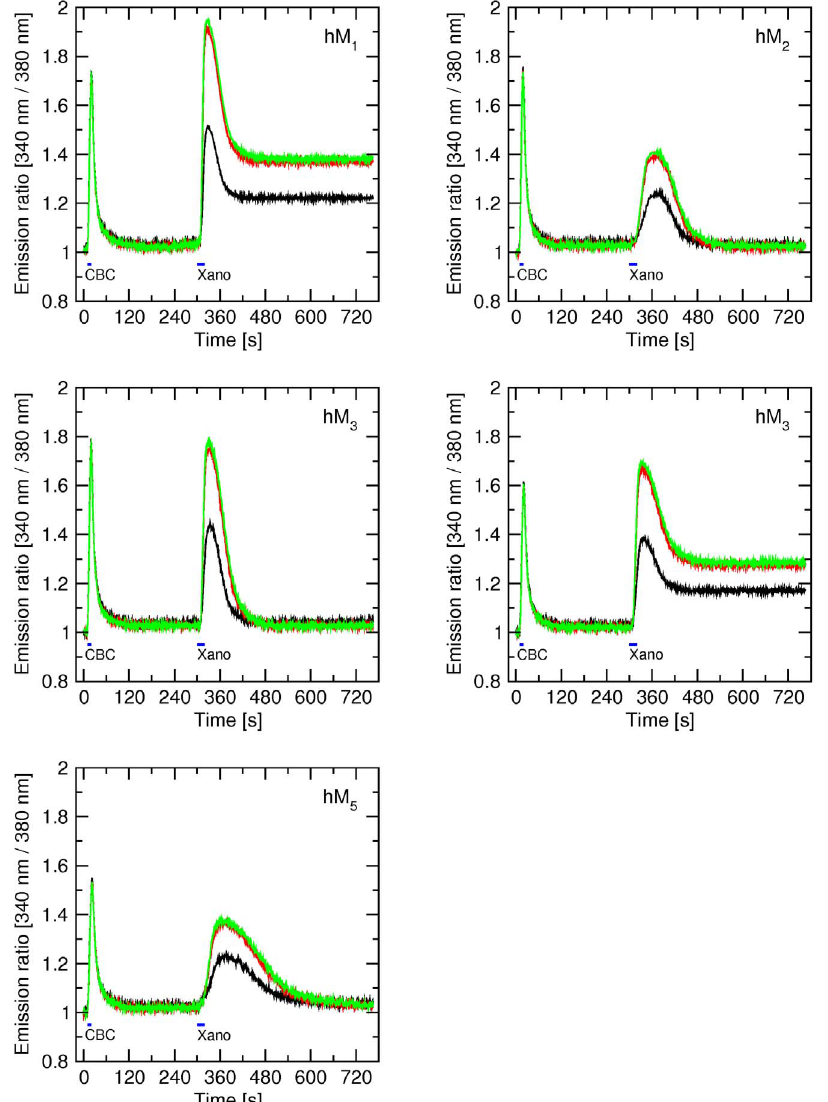
Figure 1. Concentration response to acute treatment with xanomeline. Cells were seeded, handled and loaded with Fura-2 as described in Methods. After an initial 10-s period cells were stimulated with 300 nM carbachol (CBC) for 5 s, washed with KHB for 5 min, then stimulated with 0.1 (black), 1 (red) or 10 m M (green) xanomeline (Xano) for 20 s and washed with KBH for 7 min. Traces are averages from 10 to 12 cells from representative experiment confirmed by 3 independent experiments. Signal variation (SD) among cells ranges from 6 0.019 at the base line to 6 0.035 at peaks. Parameters of calcium response are summarized in Table S2 in File S1. Calculated pEC 50 and E MAX of response to xanomeline are in Table 1.